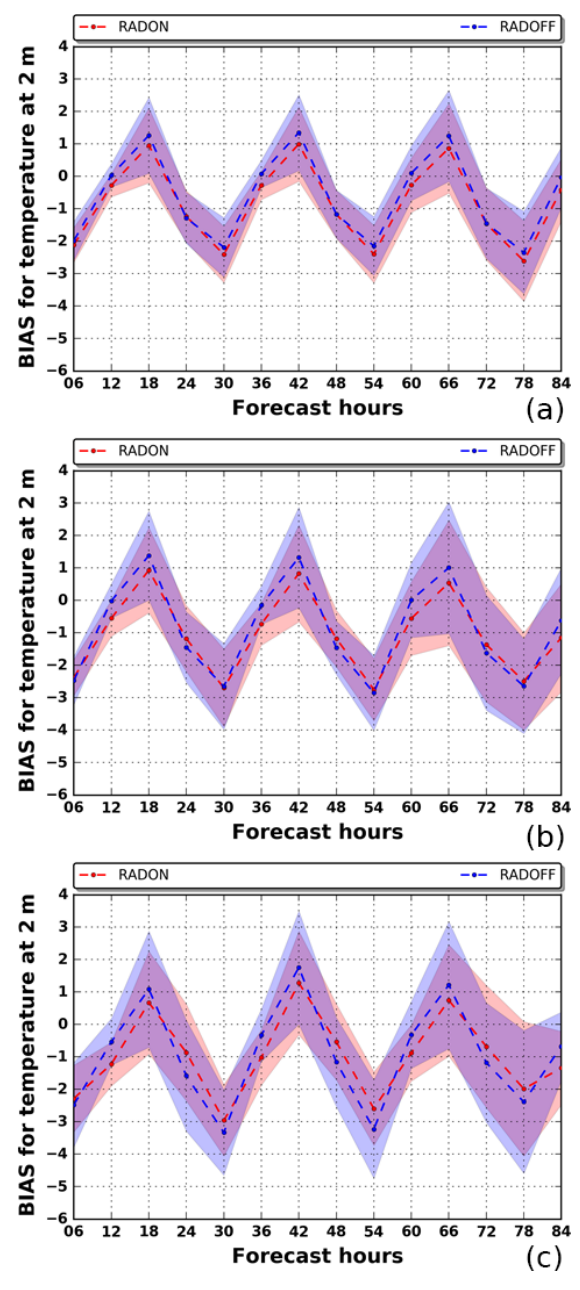
Figure 11. Regional biases of temperature at 2m between NMMB- MONARCH and FNL, at 1 ◦ × 1 ◦ spatial resolution, calculated over land grid points of the simulation domain (NSD) in which dust AOD at 550nm is higher than or equal to (a) 0.1, (b) 0.5 and (c) 1.0.